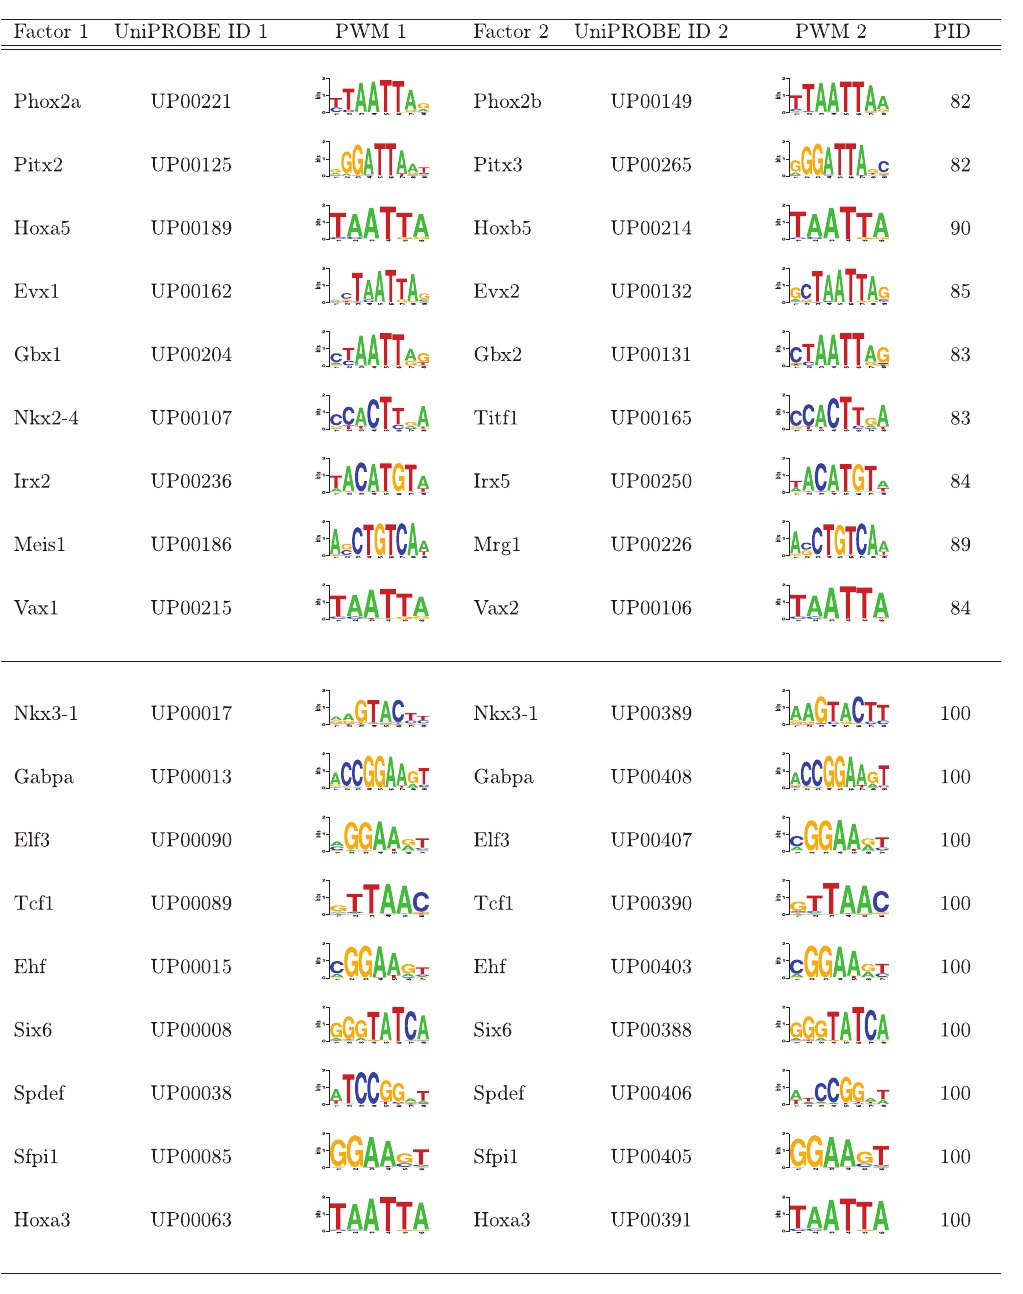
Figure 1. Data set used for validation of domain-level TF-DNA specificities. The top portion contains gene names, UniPROBE identifiers, and truncated position weight matrices for domain-identical transcription factor pairs (test set). The bottom portion contains completely-identical transcription factor pairs with replicate PBM data (control set). PID is the percent identity between the insert sequences of the transcription factor pairs used in the PBM experiments. Sequence logos were created using WebLogo [21].